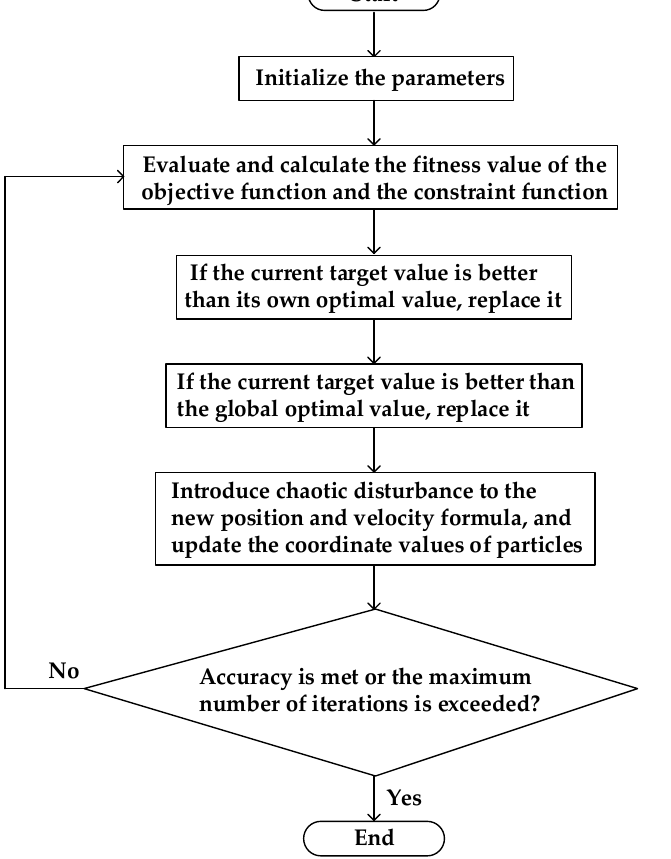
Figure 6. The flow chart of joint frequency modulation algorithm based on the CPSO.